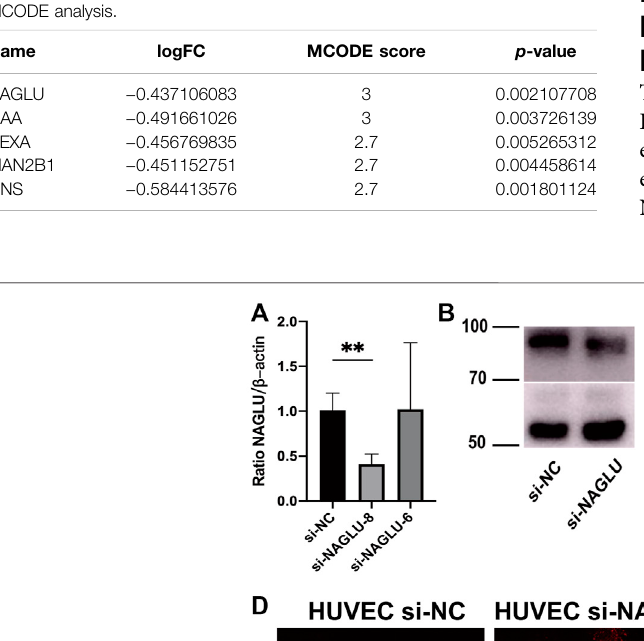
Frontiers in Cell and Developmental Biology |